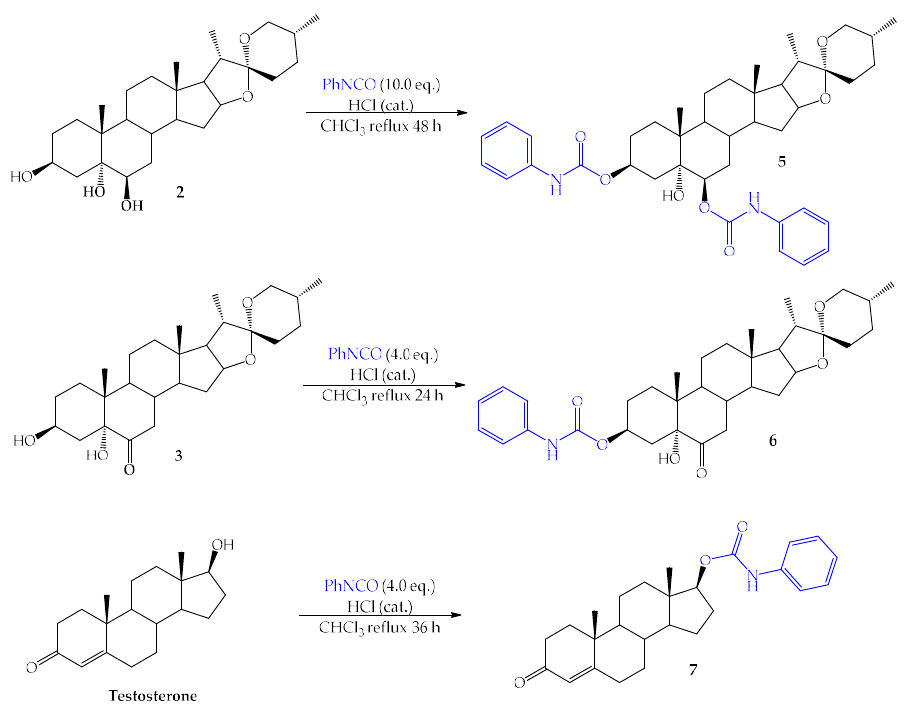
Figure 3. Diosgenin derivatives 2 and 3, and steroidal carbamate 4